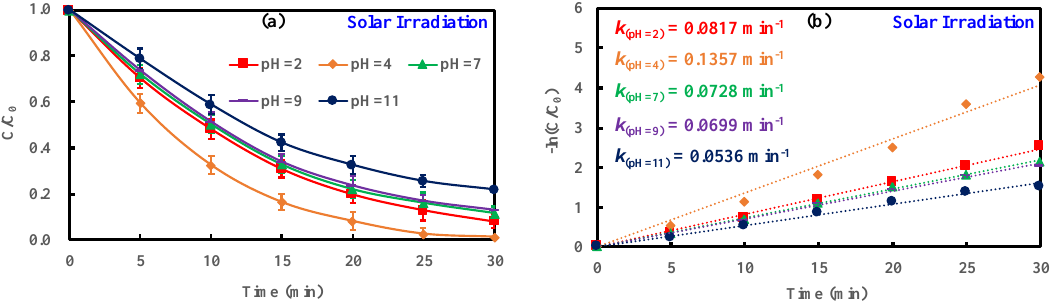
Figure 6. ( a ) Effect of pH on the photo-Fenton capability of CuFe-LDH/N-CQDs; and ( b ) pseudo-first-order kinetic fit for MB removal. Error bars represent standard deviation of triplicate runs.